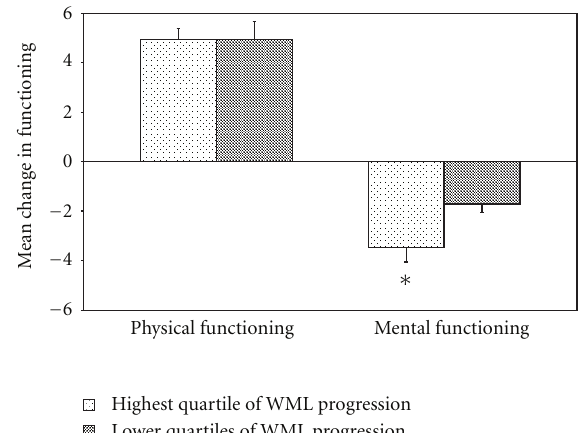
Figure 2: Mean changes in physical and mental functioning for patients with greatest progression of white matter lesion (WML) volume (highest quartile, > 0.07% increase in WML volume as % of ICV) versus patients in the lower three quartiles of progression, adjusted for age, sex, baseline functioning, and follow-up time. Significant di ff erences are indicated with an asterix.